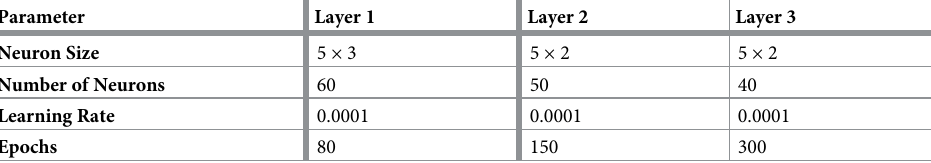
Parameter Layer 1 Layer 2 Neuron Size Number of Neurons Learning Rate 0.0001 0.0001 Epochs 80 150